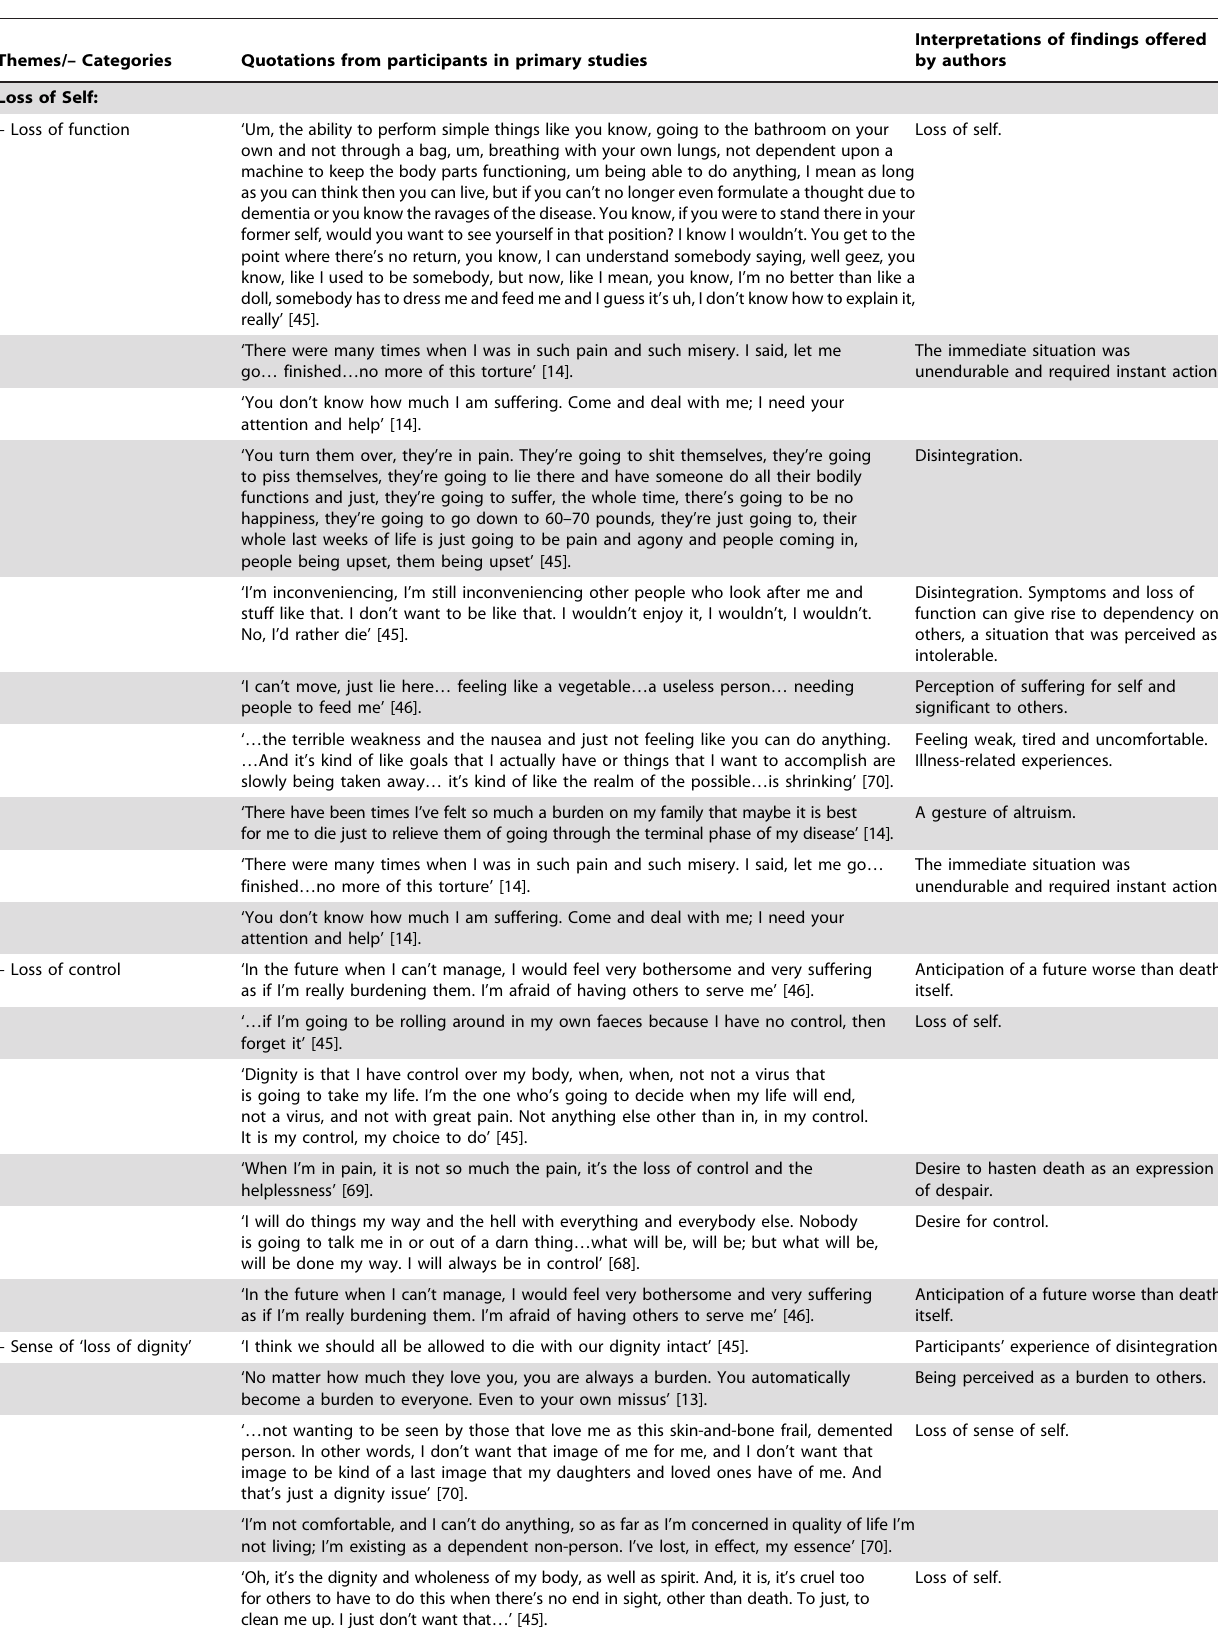
Table 3. Quotations from participants and authors of primary studies to illustrate each